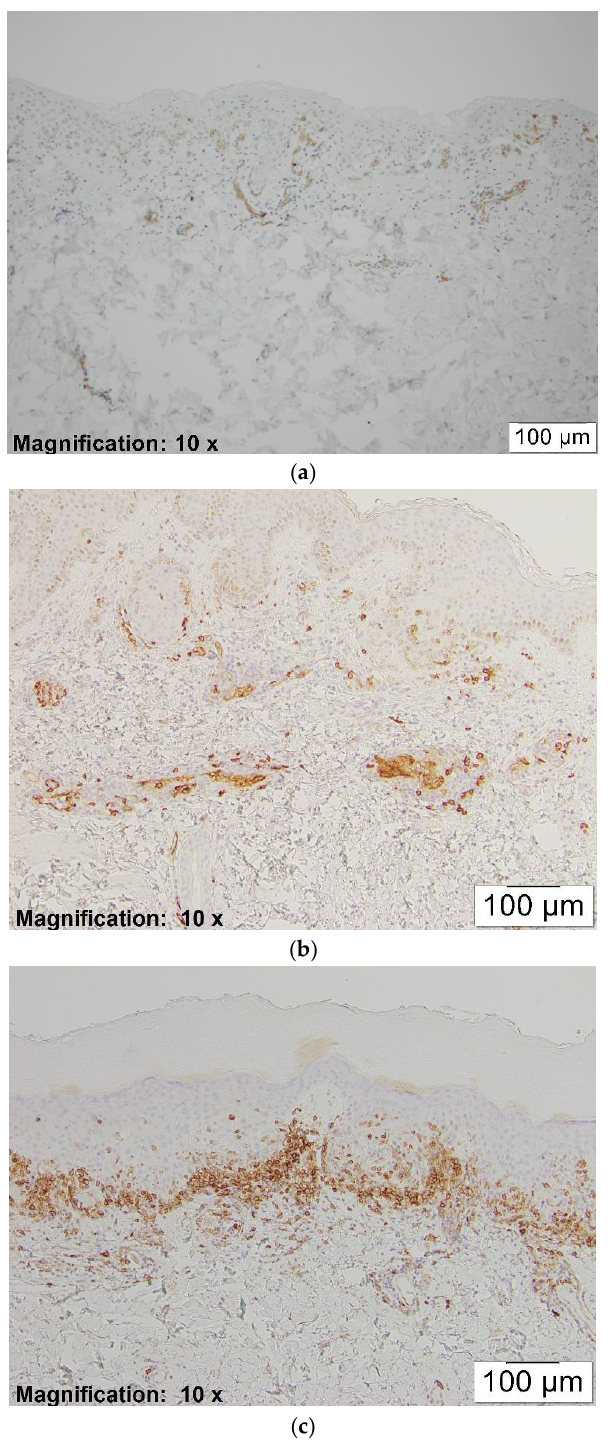
Figure 1. ( a ) CD123, ×10. This figure shows 1+ staining pattern of CD123 in drug induced erythema multiforme (EM). ( b ) CD123, ×10. This figure shows 2+ staining pattern of CD123 in other viral infection induced EM. ( c ) CD123, ×10. This figure shows 3+ staining pattern of CD123 in herpes simplex virus (HSV)-associated EM.